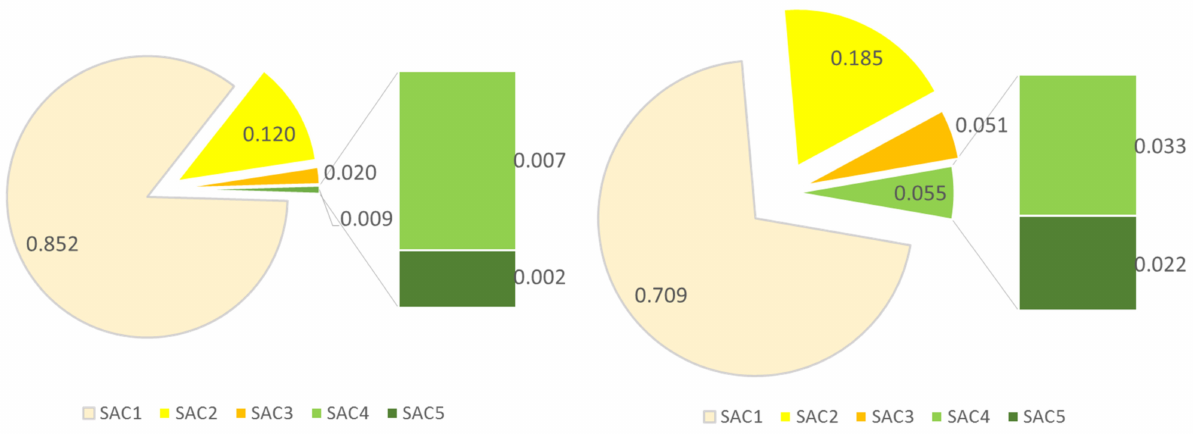
Figure 5. Distribution of slope angle classes of all parcels ( left ) and natural areas ( right